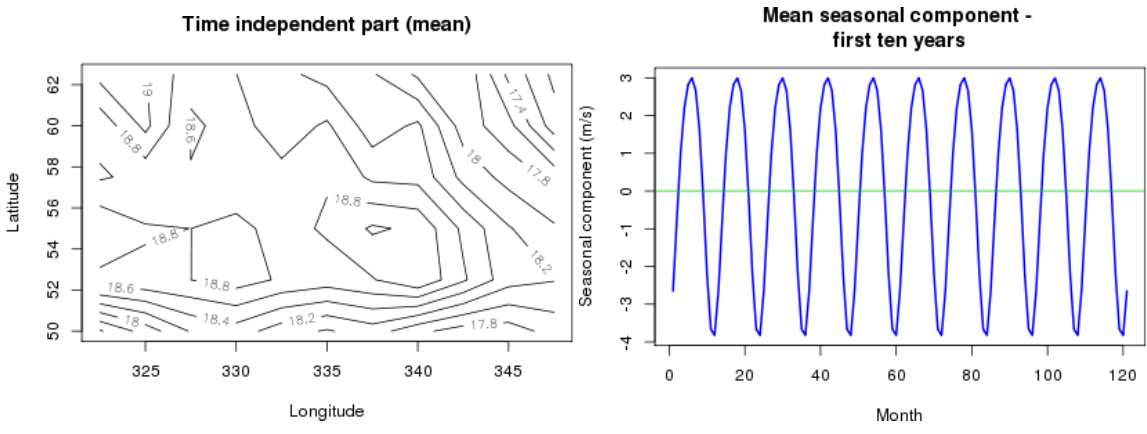
Fig. 8. Results from the model without trend; the mean spatial field and seasonal